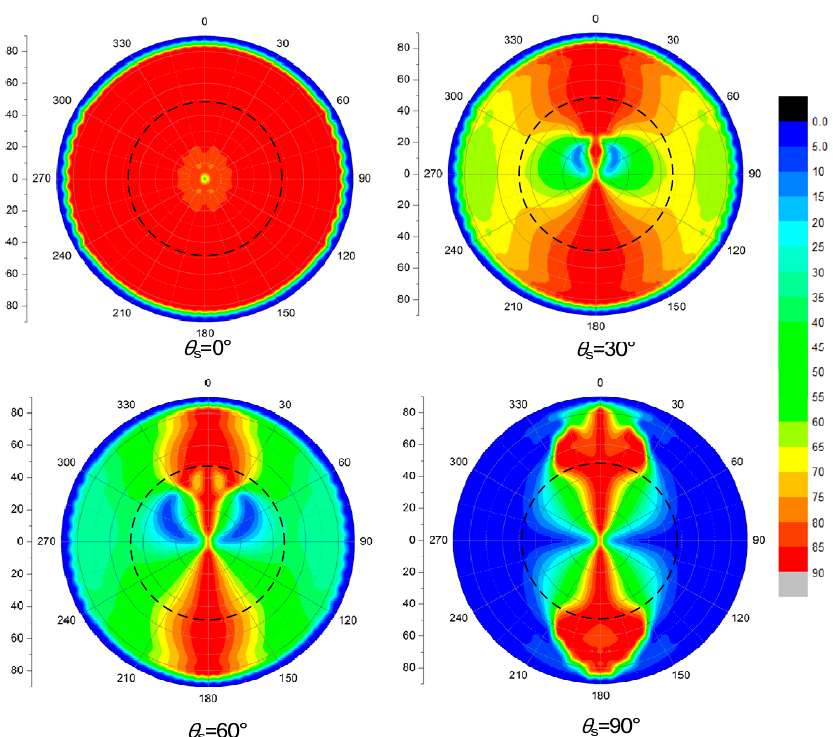
Figure 8. The AOP patterns of full incident light transmitted through a wavy water surface under different SZAs, where wind speed is 5 m/s, wind direction is 0° .